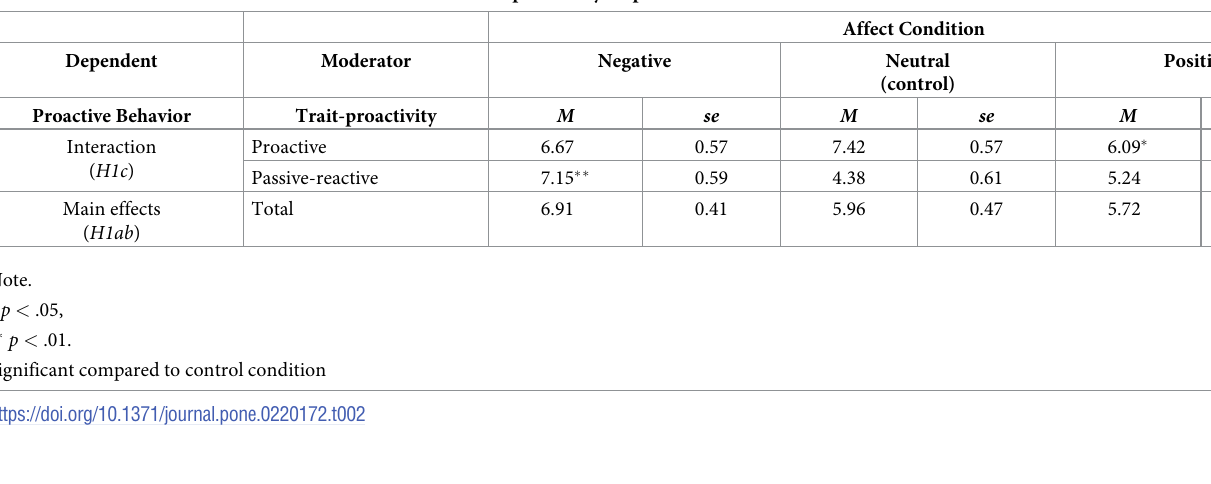
Table 2. Main and interaction effects of affect condition � trait-proactivity on proactive